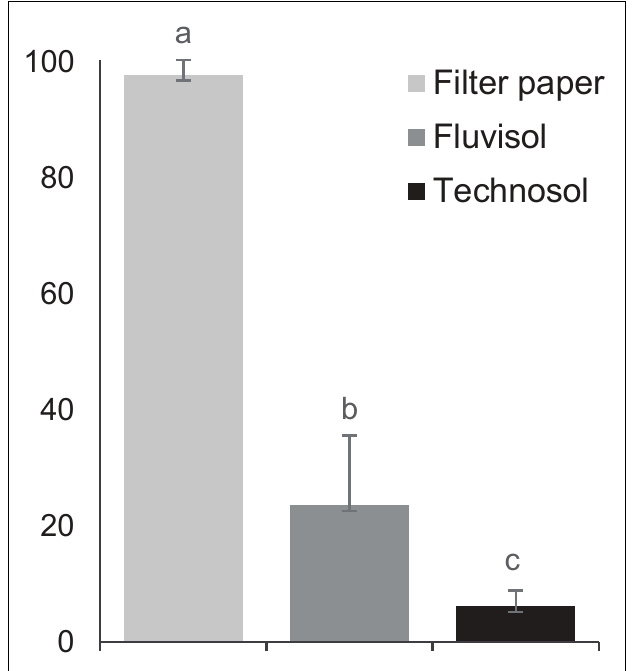
FIGURE 3 | The percentage of Limonium daveaui seeds germination (mean ± SD; n = 144). The substrata (moist filter paper, Fluvisol and Technosol) with different letters are significantly different ( p < 0.05, one-way ANOVA (substrata) followed by Tukey HSD test).